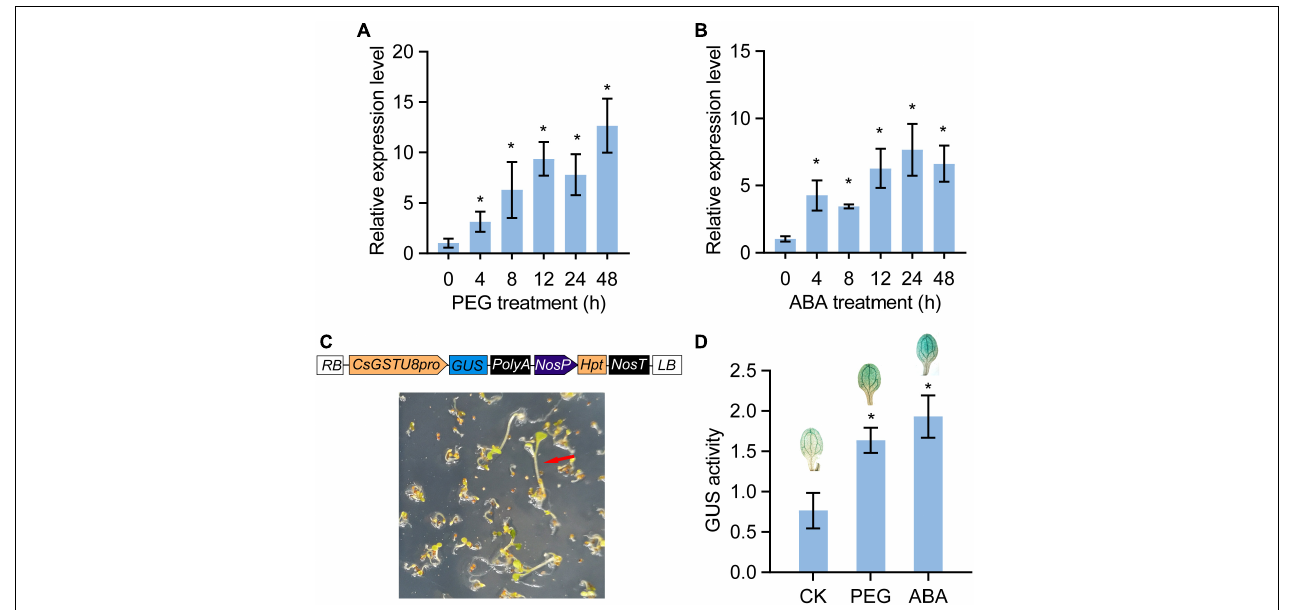
FIGURE 2 | Expression patterns of CsGSTU8 under PEG and ABA treatments. (A) Expression of CsGSTU8 after PEG treatment. (B) Expression of CsGSTU8 under ABA treatment. (C) Construction of CsGSTU8pro ::GUS transgenic lines. Hygromycin B was used to screen transgenic Arabidopsis plants. (D) Measurement of the GUS activities in CsGSTU8pro ::GUS transgenic Arabidopsis leaves under PEG and ABA treatments. The Data are presented as the means ± SDs of three independent experiments. Significant differences were determined using Student’s t -test (* P <